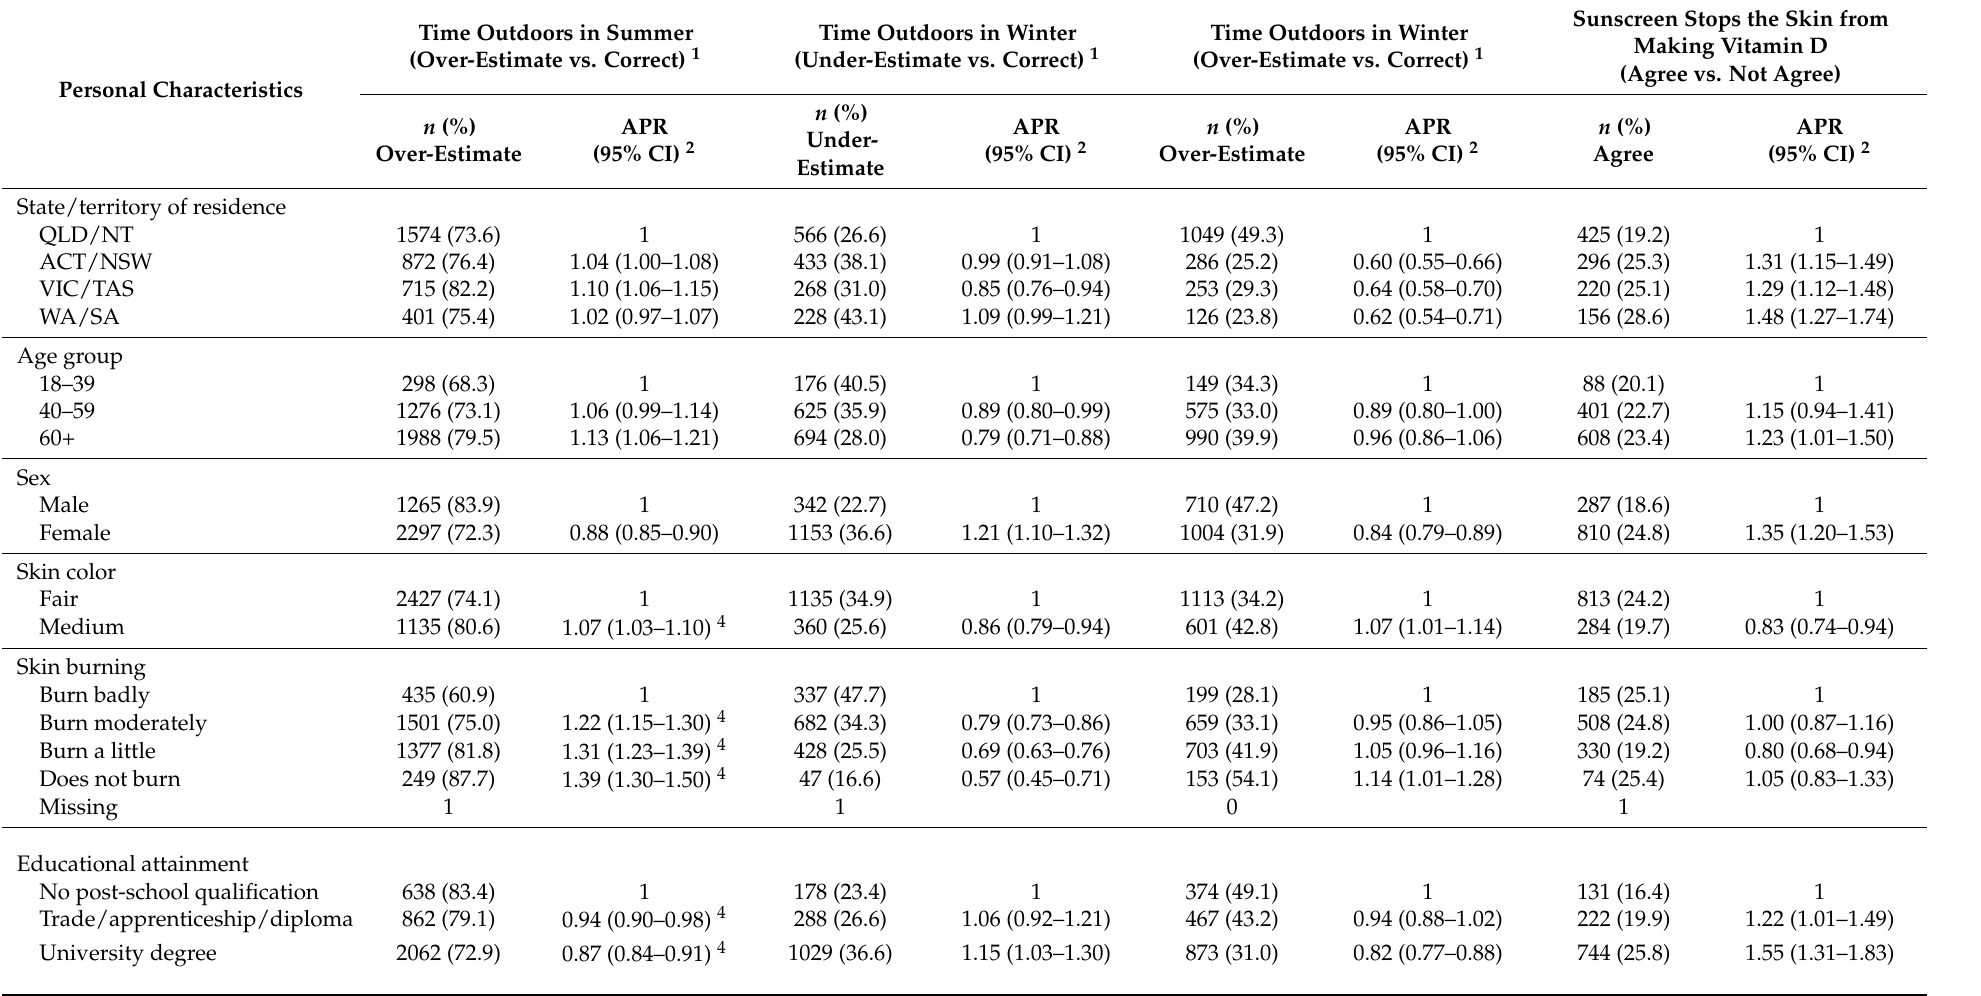
Table 3. Associations between personal characteristics and knowledge about/attitudes towards time outdoors needed to avoid vitamin D